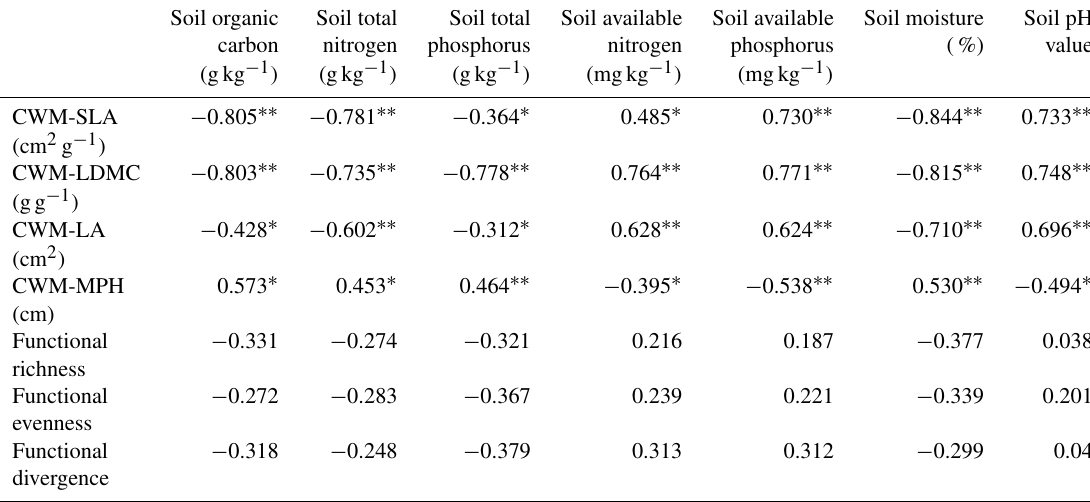
Table 2. Relationships between CWM traits and soil properties from a Pearson’s correlation analysis. Soil organic Soil total Soil total Soil available Soil available Soil moisture Soil pH carbon nitrogen phosphorus nitrogen phosphorus (%)